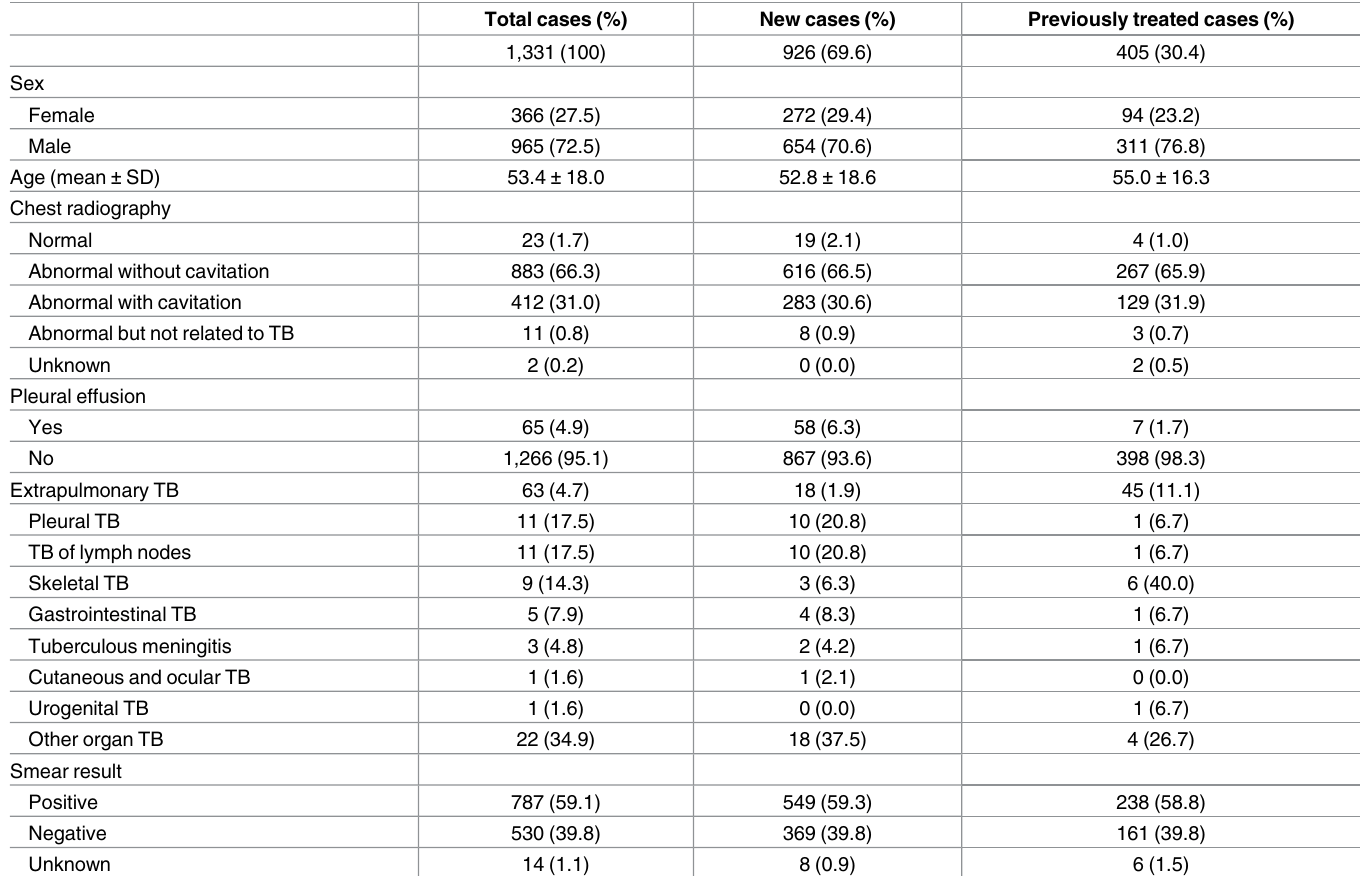
Table 1. Characteristics of MDR-TB cases in Taiwan,